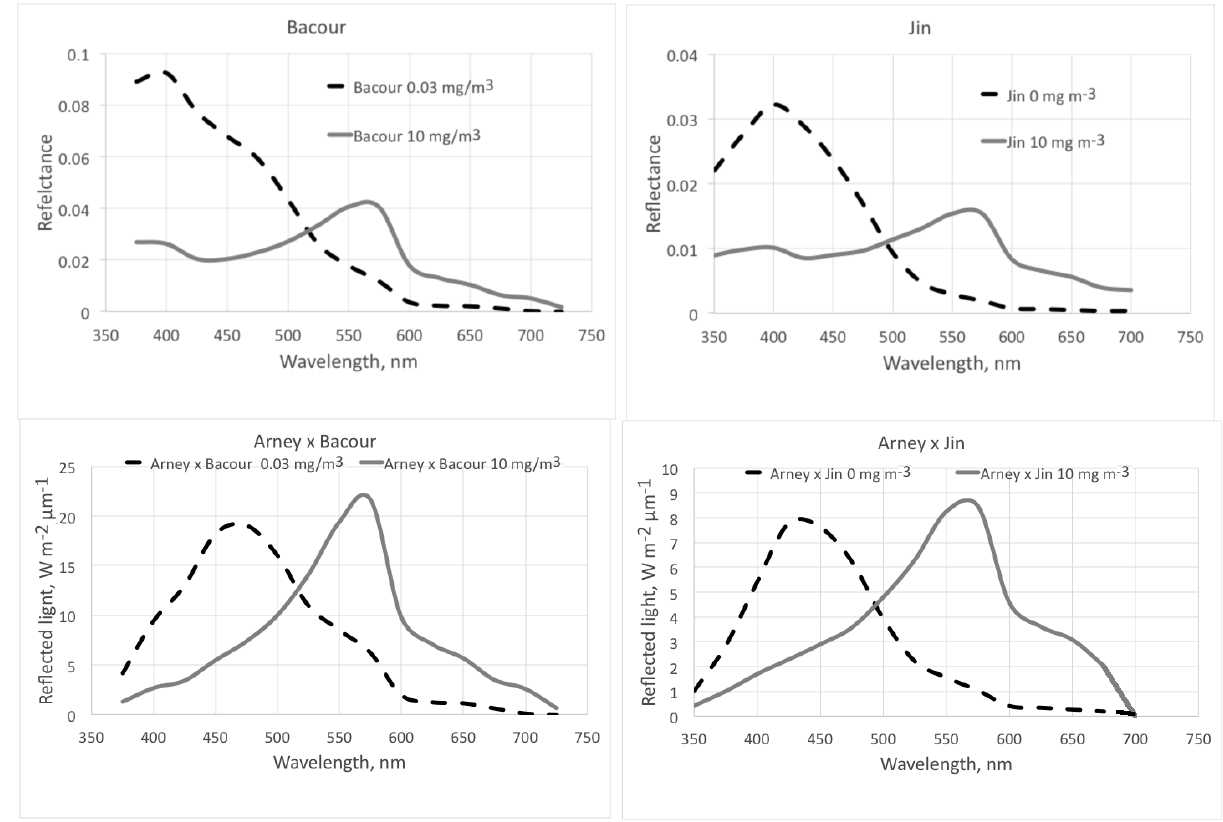
Figure 5. The effect of phytoplankton on reflectance of the ocean surface. The dashed lines are for a low chlorophyll content of the surface layer (0 or 0.03mgm − 3 ) and the solid lines for a high chlorophyll content (10mgm − 3 ). The top two graphs show the modeled spectra from Bacour et al. (2020) and Jin et al. (2011, diffuse incidence). The geometry is not the same for the two panels; thus the absolute values are not directly comparable. The lower two graphs show the amount of reflected light, assuming an incident Archaean daylight according to the red graph in Fig. 15 (right panel) of Arney et al.